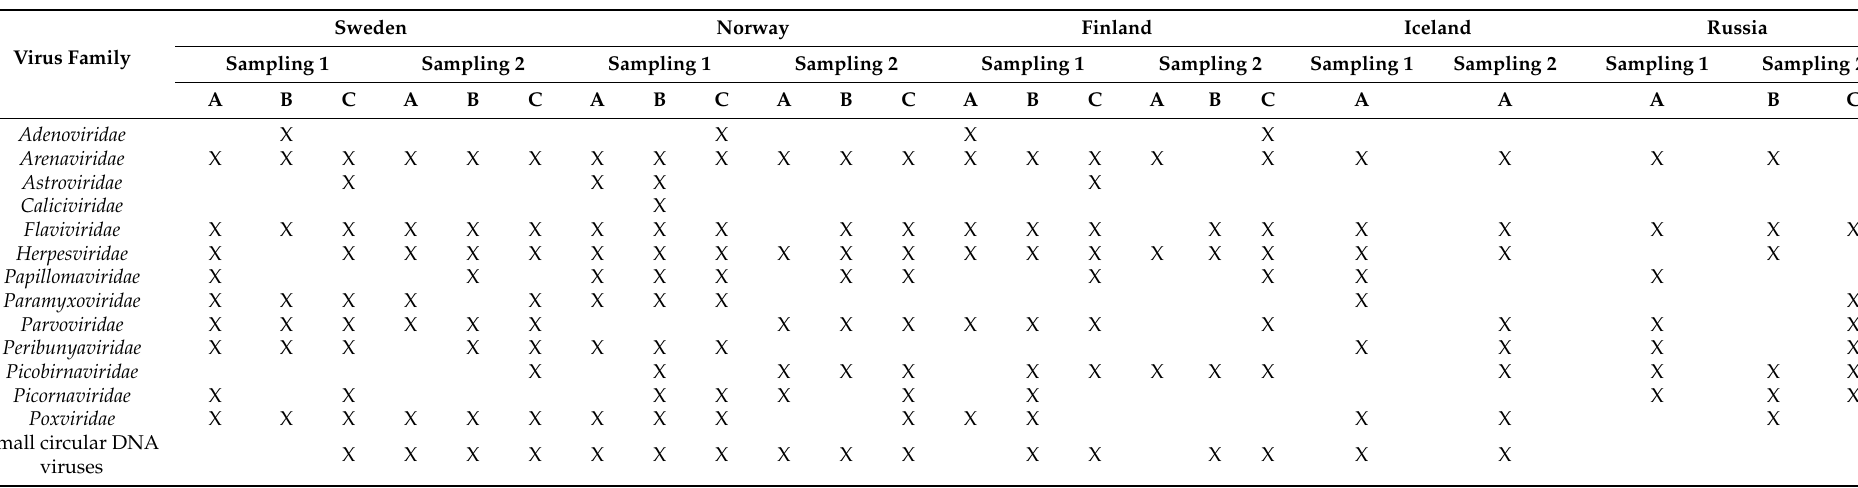
Table 4. Summary of regions with positive nasal and/or rectal swab pools (X) for viruses from selected viral families. Nasal and rectal swabs were collected from three different semi-domesticated reindeer herds in Finland, Norway, and Sweden (regions A, B, and C) and from wild reindeer in Iceland (region A) in in two consecutive sampling years (samplings 1 and 2). Nasal and rectal swabs were collected and pooled from one semi-domesticated reindeer herd in Yakutia, Russia, in 2016 (region A) and two different herds in 2019 (regions B and